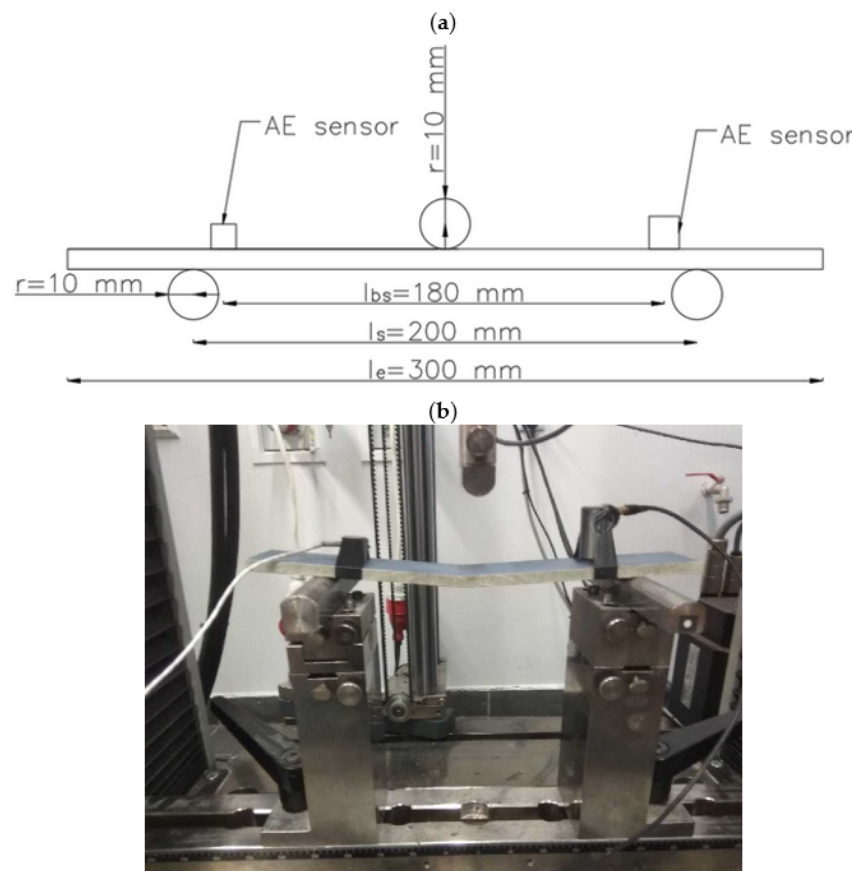
Figure 1. Test stand diagram: ( a ) load diagram; ( b ) a photograph of one of the samples.